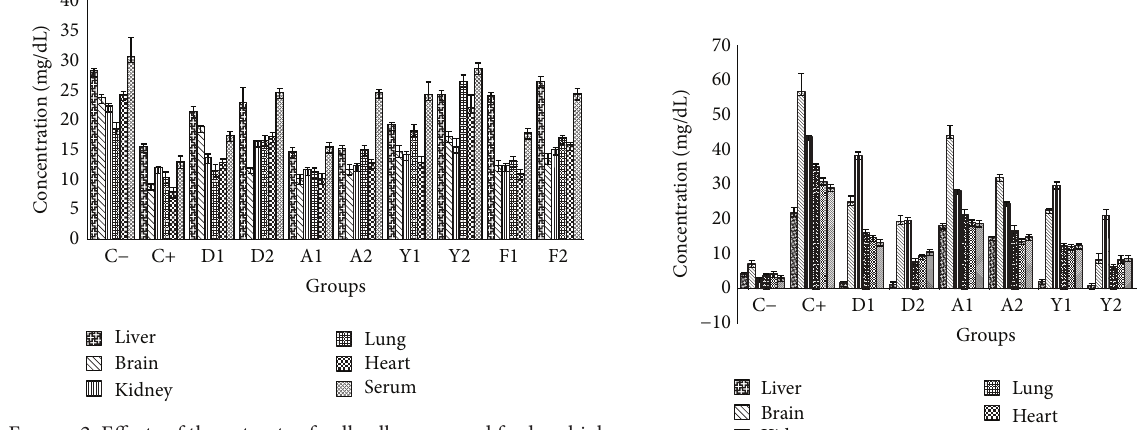
Figure 2: Effects of the extracts of yolk, albumen, and feed on high density lipoprotein profiles in liver, brain, kidney, lung, heart, and serum (mg/dL). Each value represents mean ( 𝑛 = 5 ).